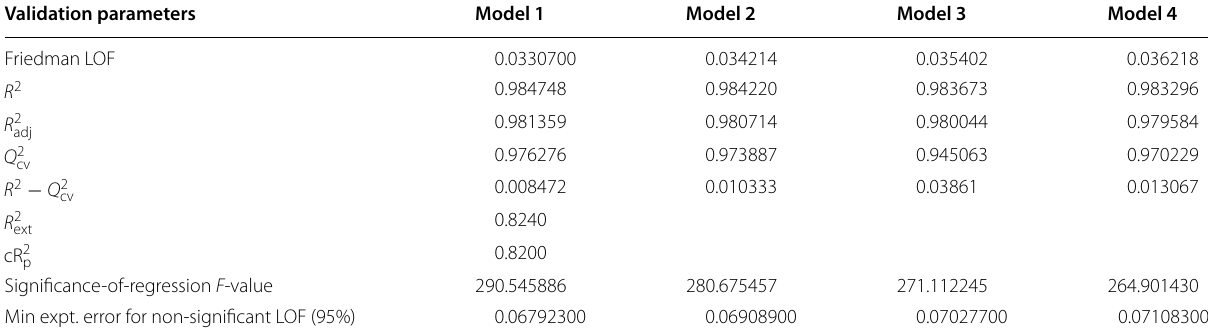
Table 3 QSAR model validations values